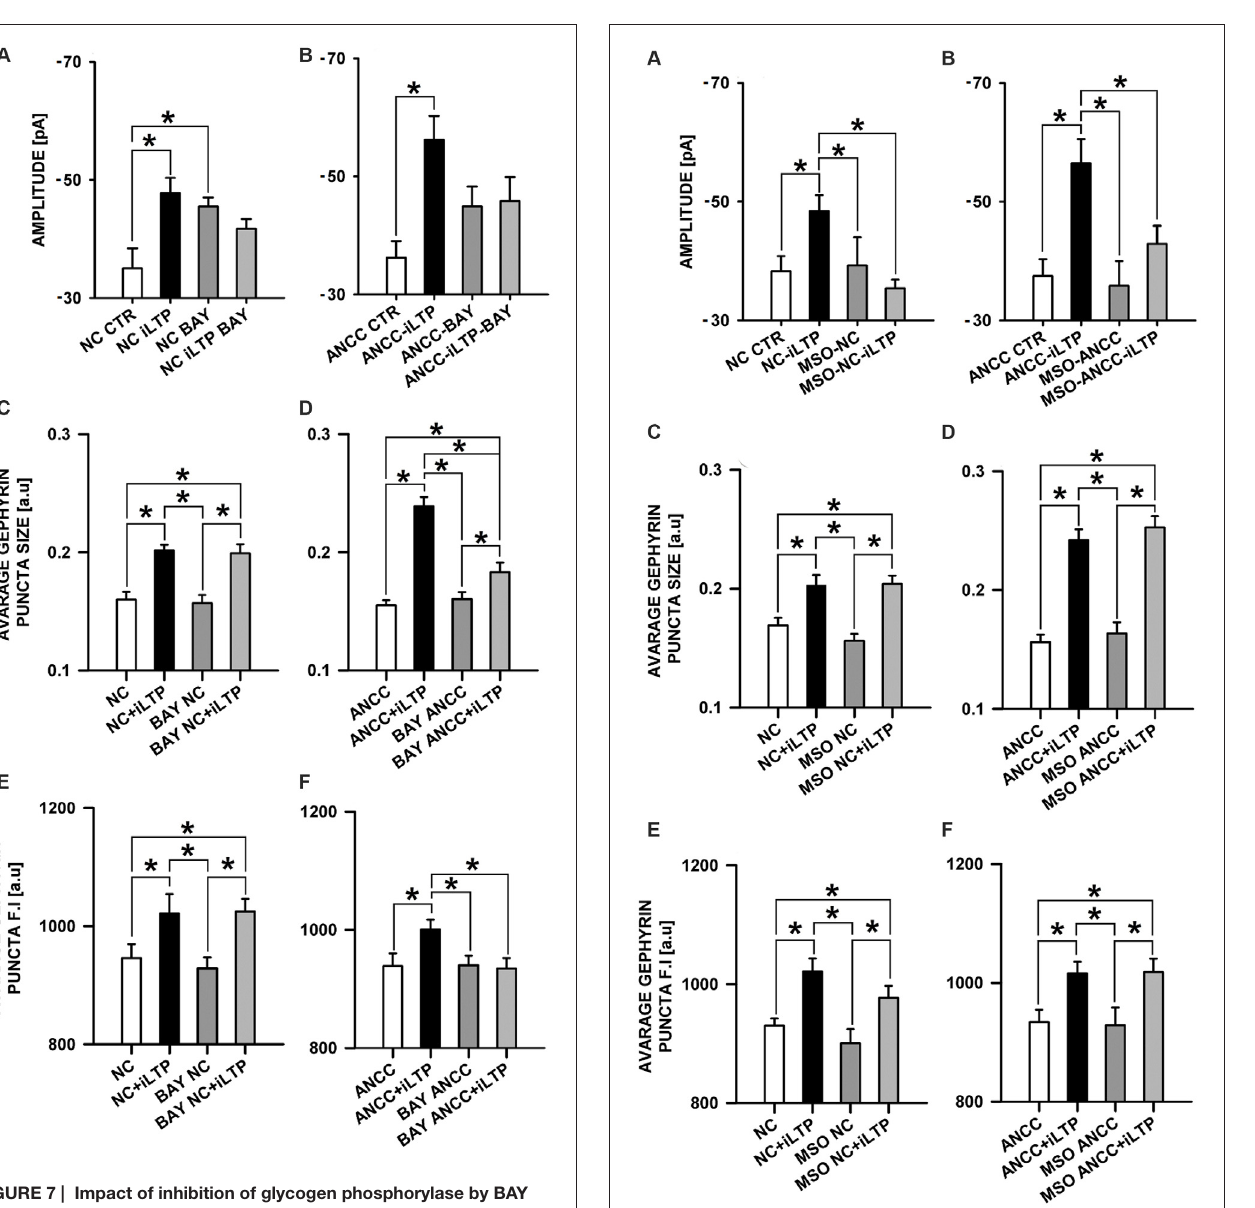
both NC and ANCC kinetic characteristic of mIPSC in MSO treatment group remain unchanged (rise time: 1.54 ± 0.06 ms in NC, 1.59 ± 0.07 ms in MSO NC, 1.59 ± 0.09 ms